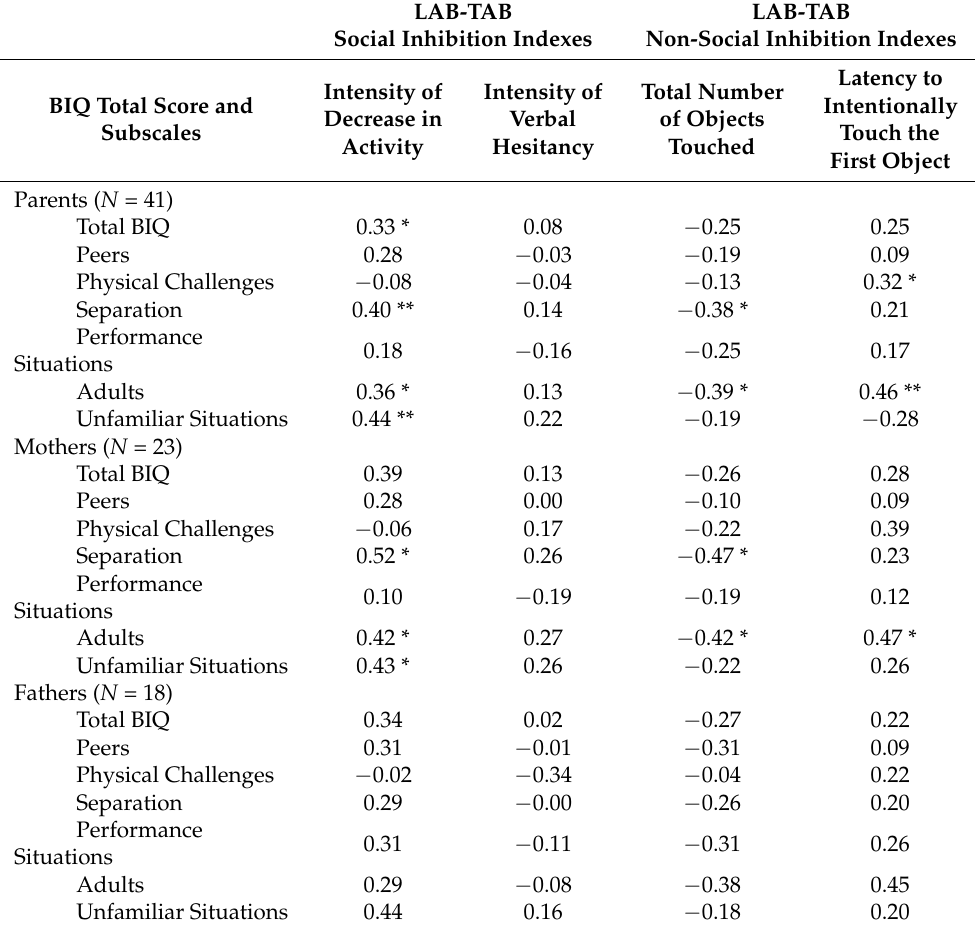
Table 7. Correlations between BIQ subscales and LAB-TAB indexes.